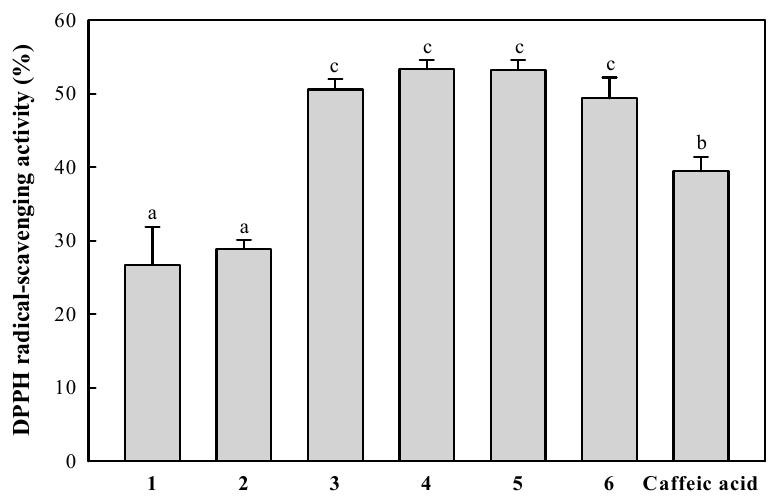
Figure 3. DPPH radical-scavenging activity of the isolated compounds. Each value is the mean ± standard deviation (SD) of three experiments. a–c Results with a different letter differ significantly ( p < 0.05).